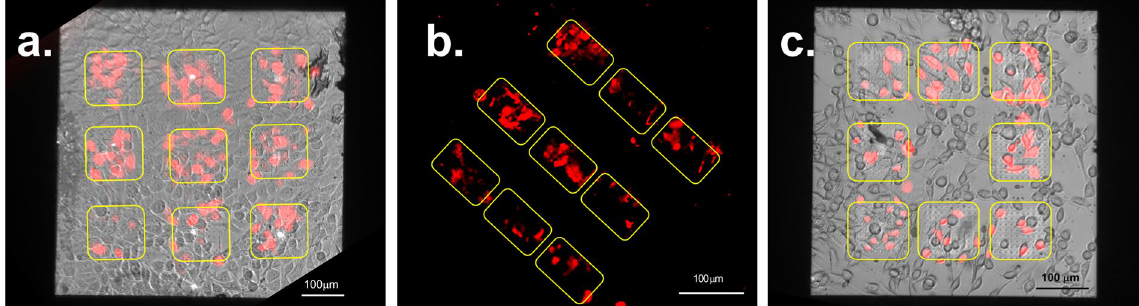
Figure 5. ( a – c ) Different spatial arrangement of the 3D hollow nanoelectrodes arrays framed by the yellow squares. Only the cells grew in adhesion with the hollow nanostructures are delivered with PI (in red) after the soft-electroporation. Cells in the images are NIH-3T3 and the scale bar is 100 μ m for each